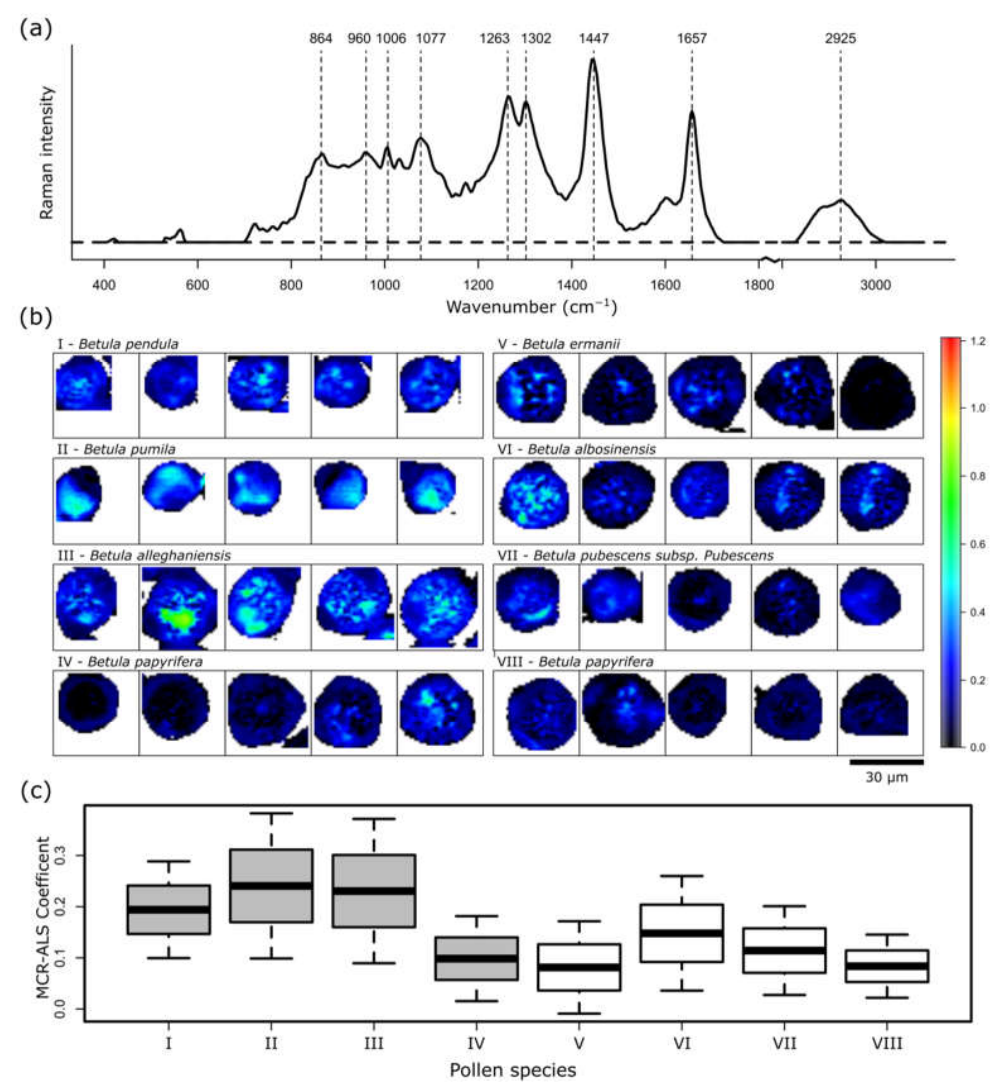
Figure 6. MCR-ALS results for a component representing lipid and protein content. ( a ) Calculated spectrum, ( b ) spatial distribution and ( c ) mean concentration of the components of seven different pollen species. Pollens ( I – IV ) were collected in the Botanic Garden Jena of the Friedrich Schiller